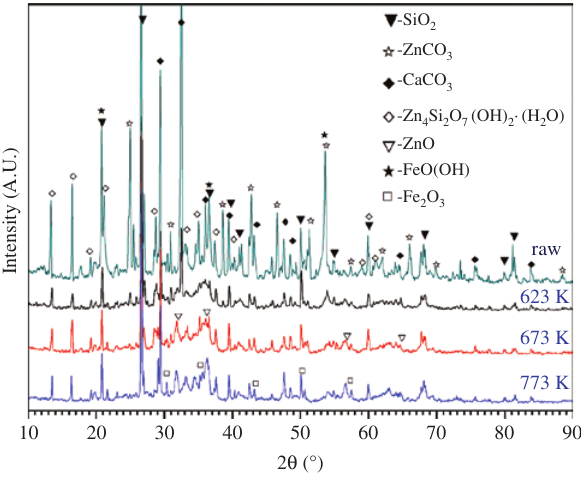
Figure 1: X-ray diffraction (XRD) patterns of complicated zinc ore before and after being roasted at various temperatures.